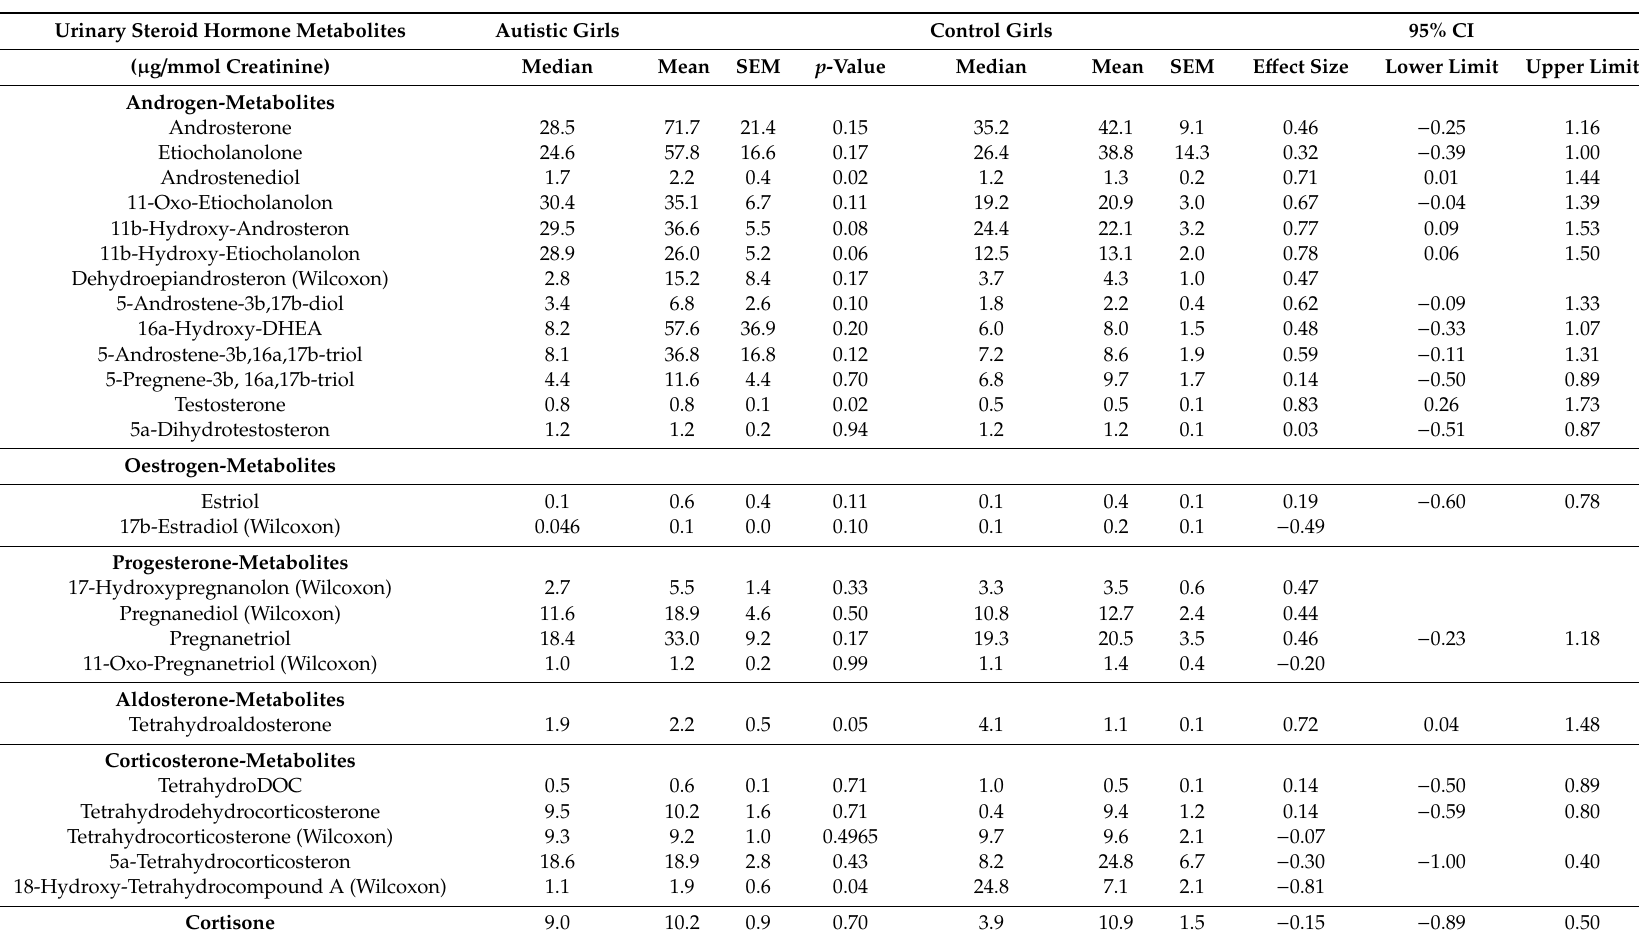
Table 1. Encompassing steroid hormone metabolites of a ff ected autistic girls versus individually pairwise matched controls ( n = 16). The term Wilcoxon behind the metabolite indicates that Wilcoxon tests instead of two-sided heteroscedastic t -tests were